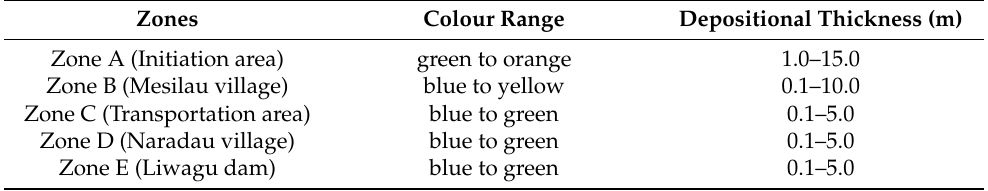
Table 6. The depositional thicknesses for every